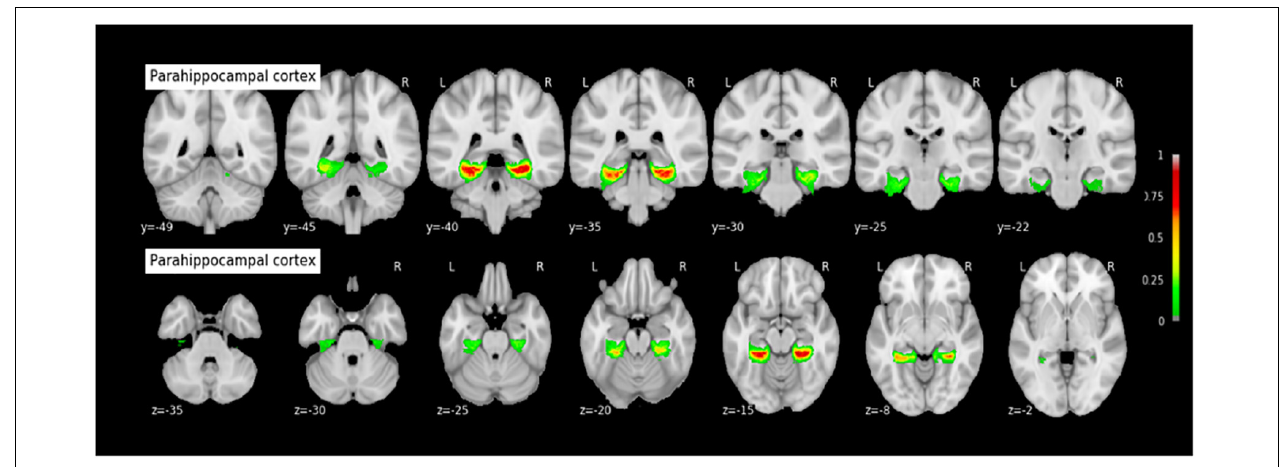
FIGURE 10 | Probabilistic map of the parahippocampal cortex (PHC). The maps are normalized into the MNI stereotaxic space. Coordinates are indicated on each